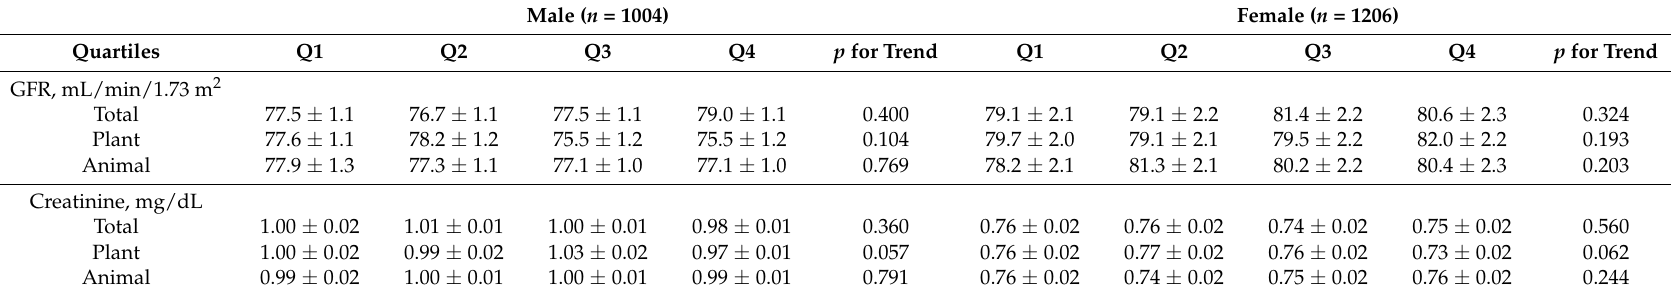
Table 3. Adjusted GFR and serum creatinine of kidney function by quartiles of daily total, plant, and animal protein intake per weight in Korean elderly population. Male ( n = 1004) Female ( n = 1206) Quartiles p for Trend GFR, mL/min/1.73 m